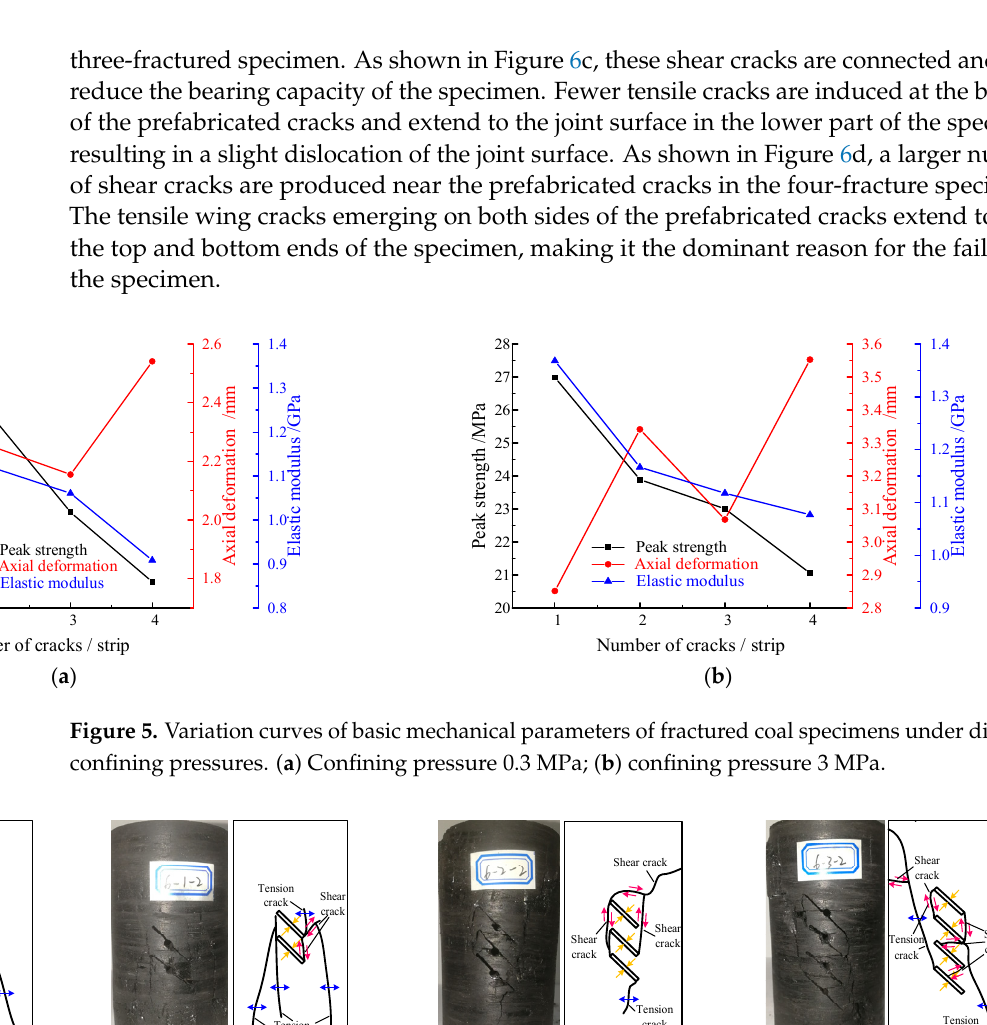
Figure 5. Variation curves of basic mechanical parameters of fractured coal specimens under differ- ent confining pressures. ( a ) Confining pressure 0.3 MPa; ( b ) confining pressure 3 MPa.